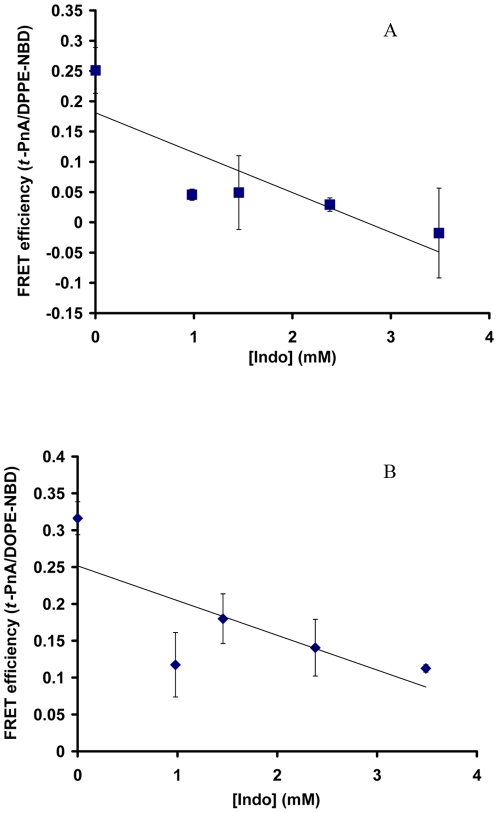
Effect of Indo on FRET efficiency in the mixed membrane (DOPC/DPPC/Chol, 1∶1∶1).Effect of Indo on the efficiency of energy transfer between t-PnA (gel phase) and DPPE-NBD (Lo phase) (A); and between t-PnA and DOPE-NBD (liquid phases) (B) in the mixed DOPC/DPPC/Chol (1∶1∶1) membrane. The marked decrease in FRET efficiency (p<0.05) indicates significant increase in the distance between the probes and potential separation of gel-phase domains from liquid-phase domains. Trend lines are present to aid the eye of the reader.